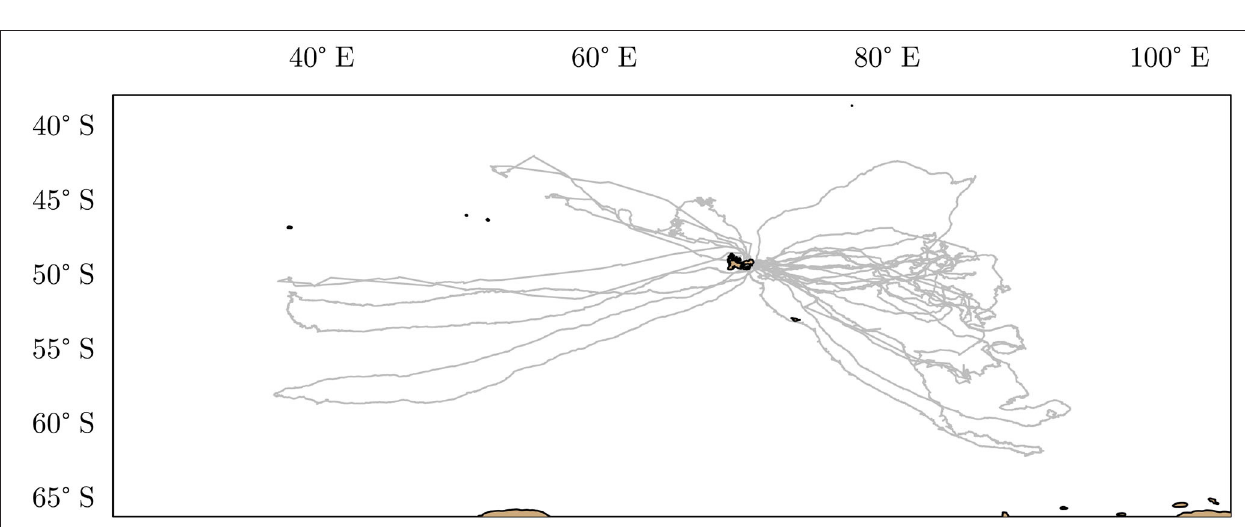
FIGURE 3 | Post-breeding foraging trips around the Kerguelen Islands of 17 female southern elephant seals equipped between October 2010 and October 2017 (gray lines). The coastline’s contours are indicated in black, and land areas are in brown. the curve must go through some points or if the derivative of some additional pointwise constraints while keeping a simple the curve must have some values on some particular points solution to the regression problem (Ramsay and Silverman, (see Supplementary Material 2005). These constraints can take various forms, especially if